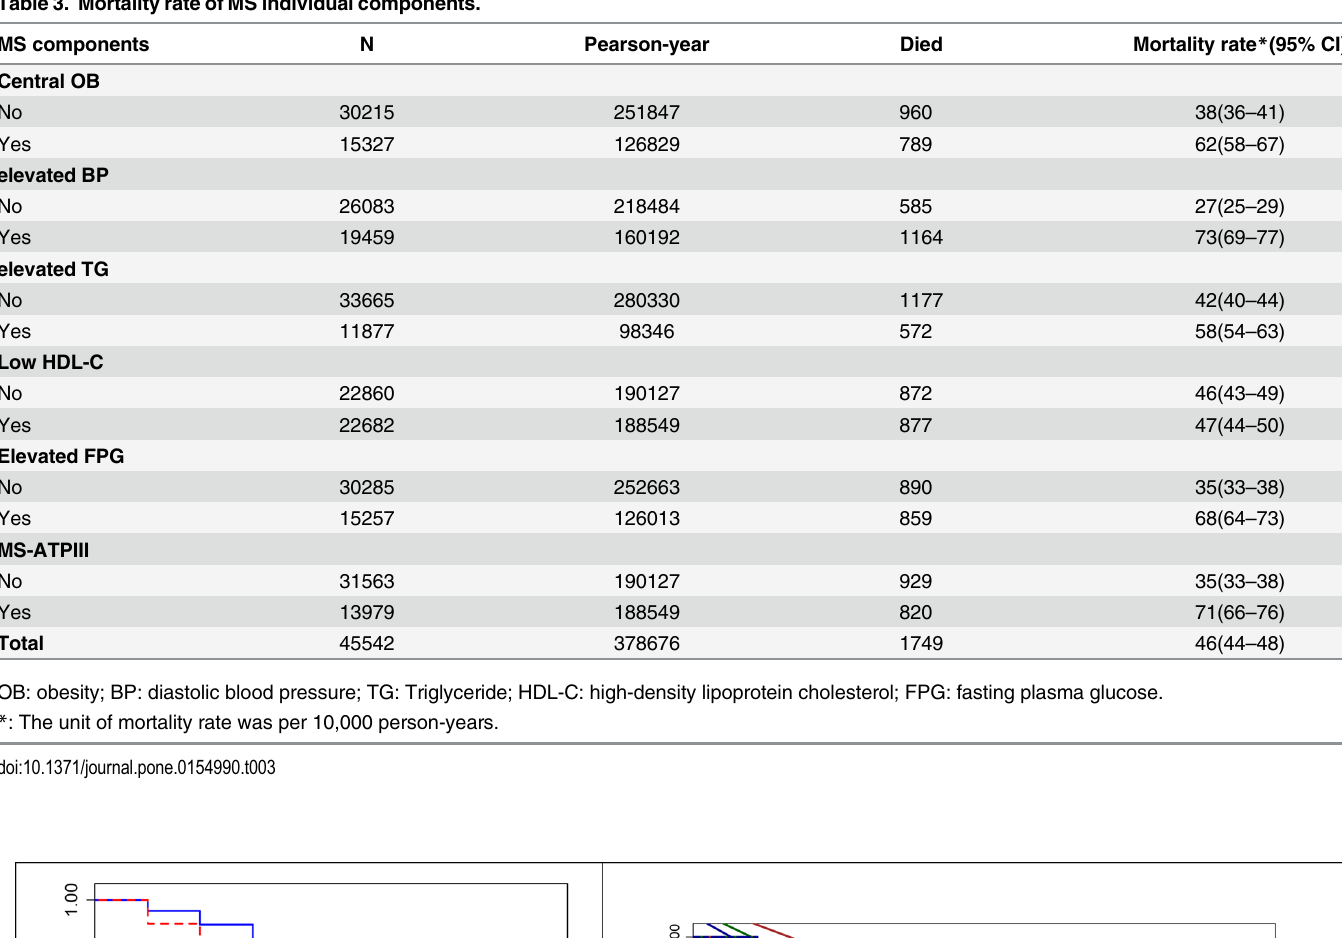
Table 3. Mortality rate of MS individual components.